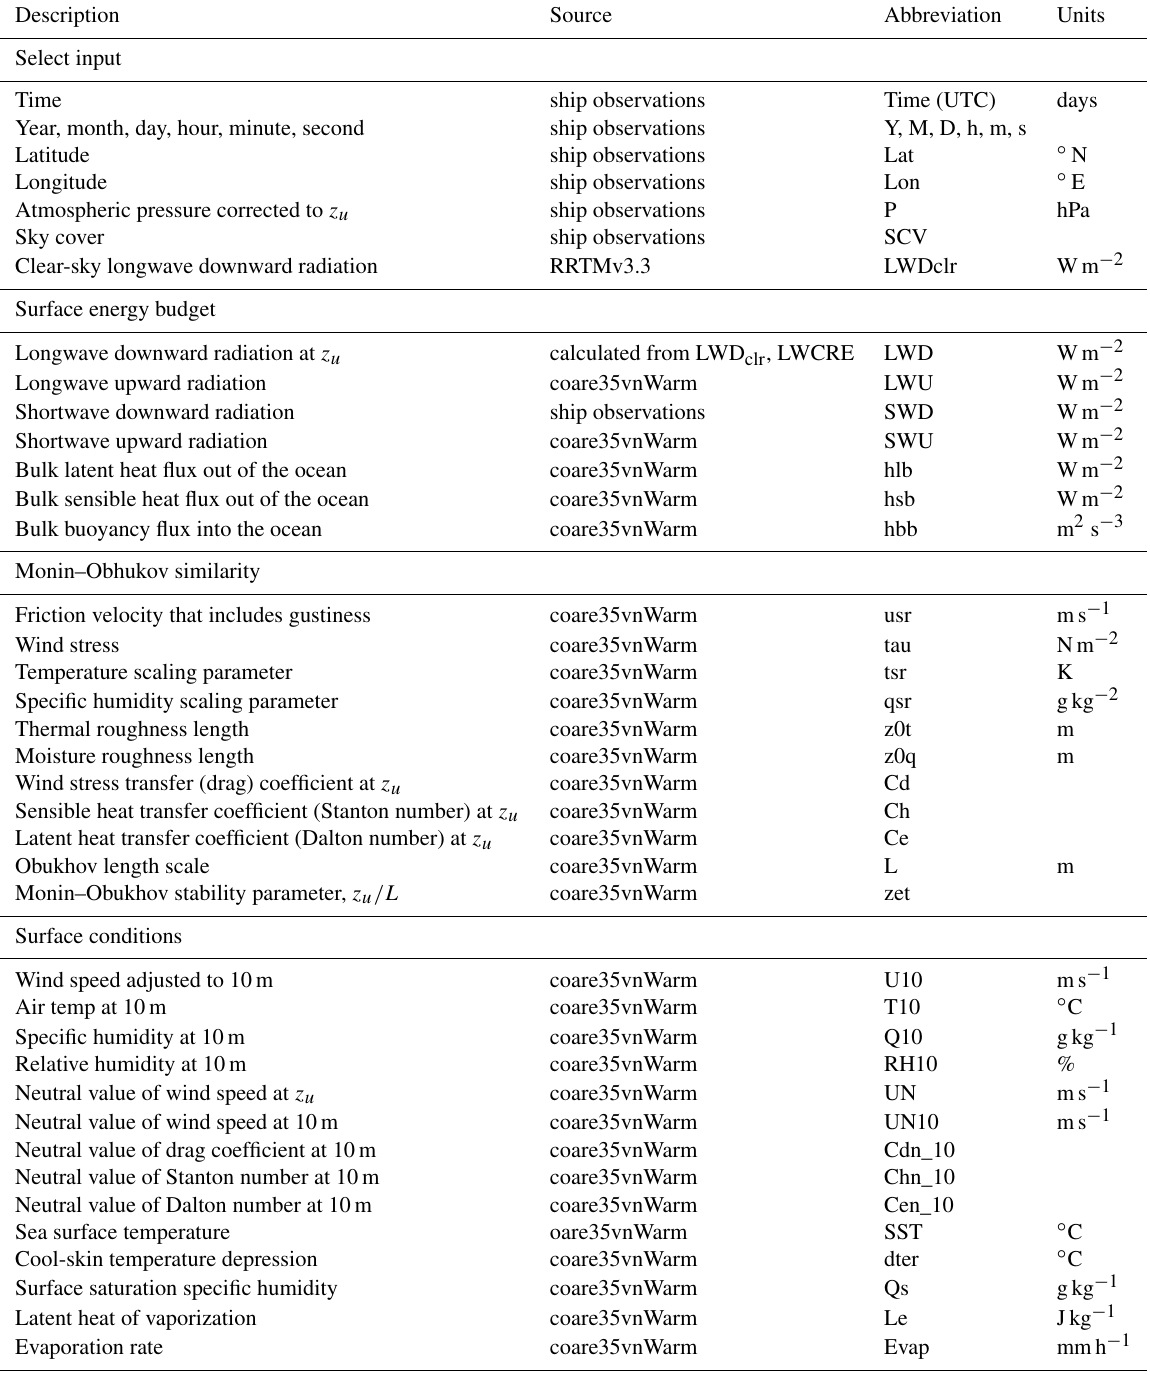
Table 5. Variables, all at hourly resolution, contained in the surface flux data file. The RRTMv3.3 algorithm is described in Mlawer et al. (1997) and the coare35vnWarm algorithm in Edson et al. (2013). The height of the input winds, 3.8ma.s.l., is denoted by z u and the Obukhov length by L